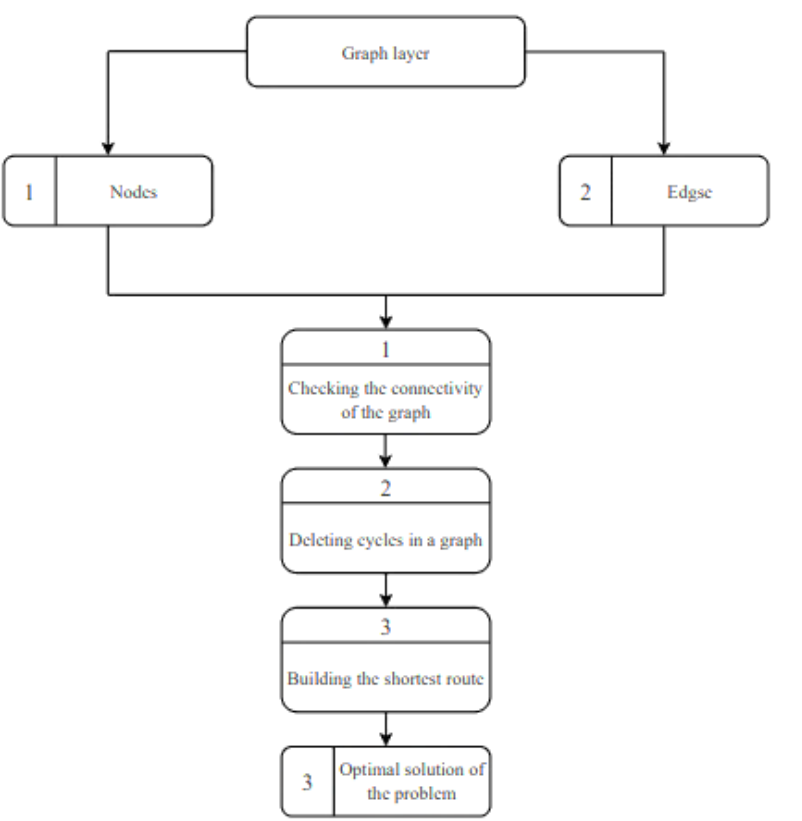
Figure 3. DFD diagram of the Bellman – Ford algorithm with modification .